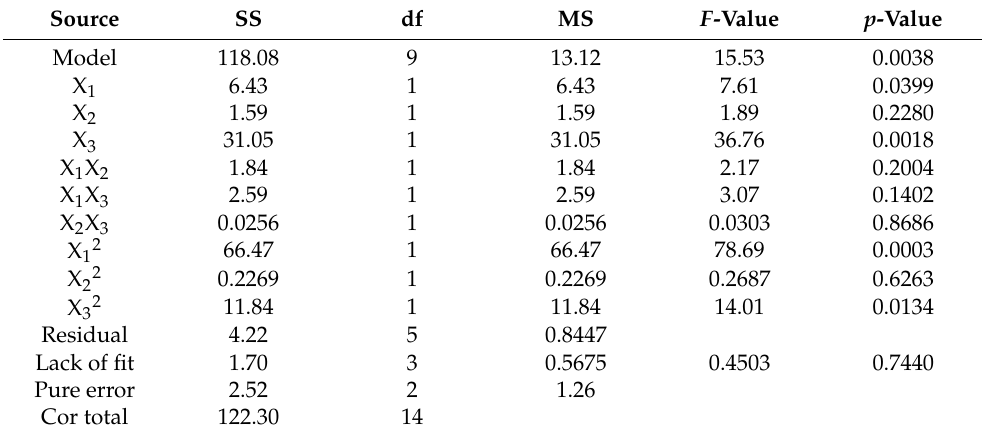
Table 3. ANOVA for RSM